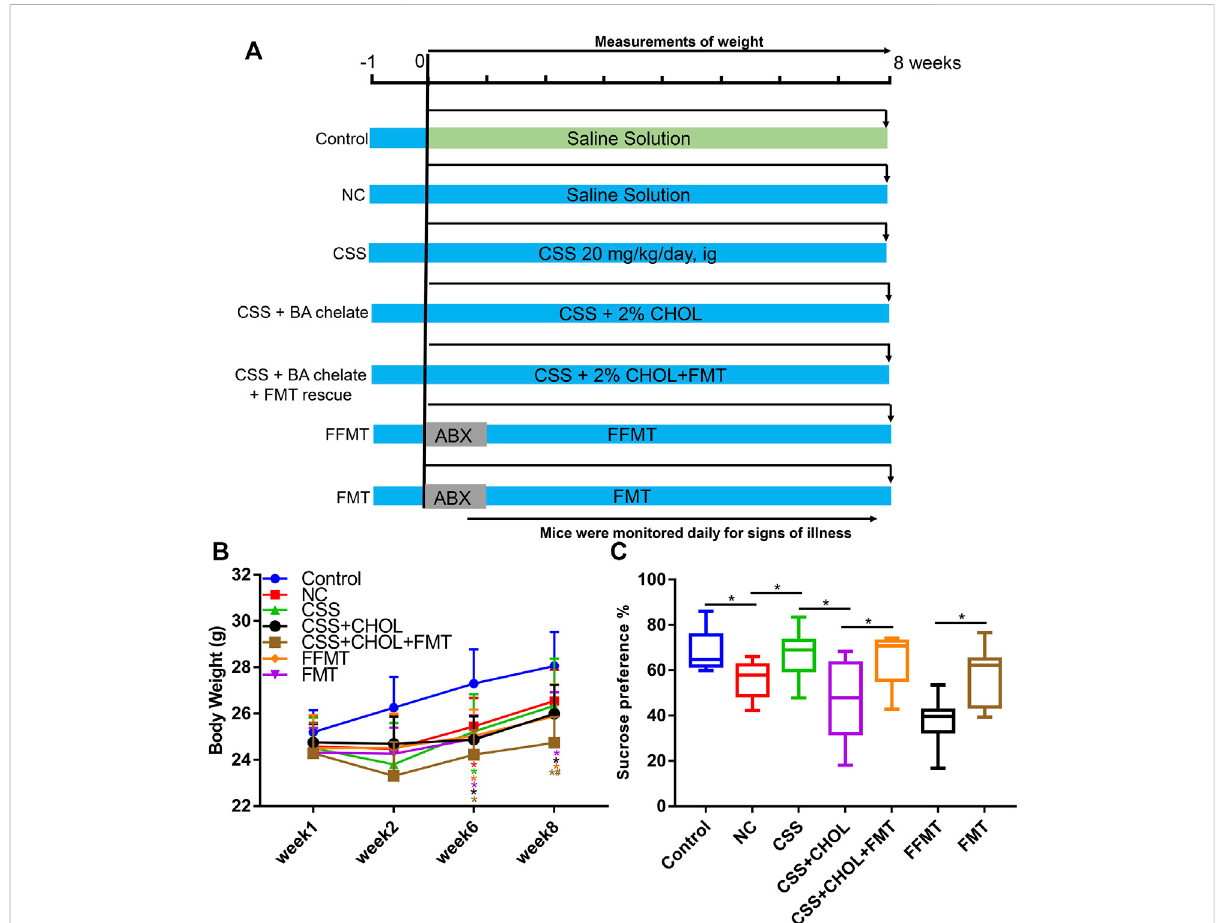
FIGURE 6 Transplantation of microbiota from CSS-treated mice into untreated mice alleviates depression-like symptoms after exposure to CUMS. Mice were exposed to CUMS and treated with saline (NC group), CSS, or CSS along with the BA sequestrant CHOL. Control mice received saline but were not exposed to CUMS. Additional groups of CUMS mice were treated with antibiotics (ABX) and then received fecal microbiota from CSS-treated groups (FMT) or fi ltered FMT (FFMT) to remove microbiota. (A) Overview of experimental groups and timelines. (B) Body weights of mice measured1,2,6,and8 weeksafter initiatingtheexperiment. (C) Percentsucrosepreferencefromeachgroup(basedonconsumptionof1%sucrose in the sucrose preference test). All values are expressed as the mean ± S.D. An asterisk “ * ” indicates p < 0.05 ( n = 7-8 mice per